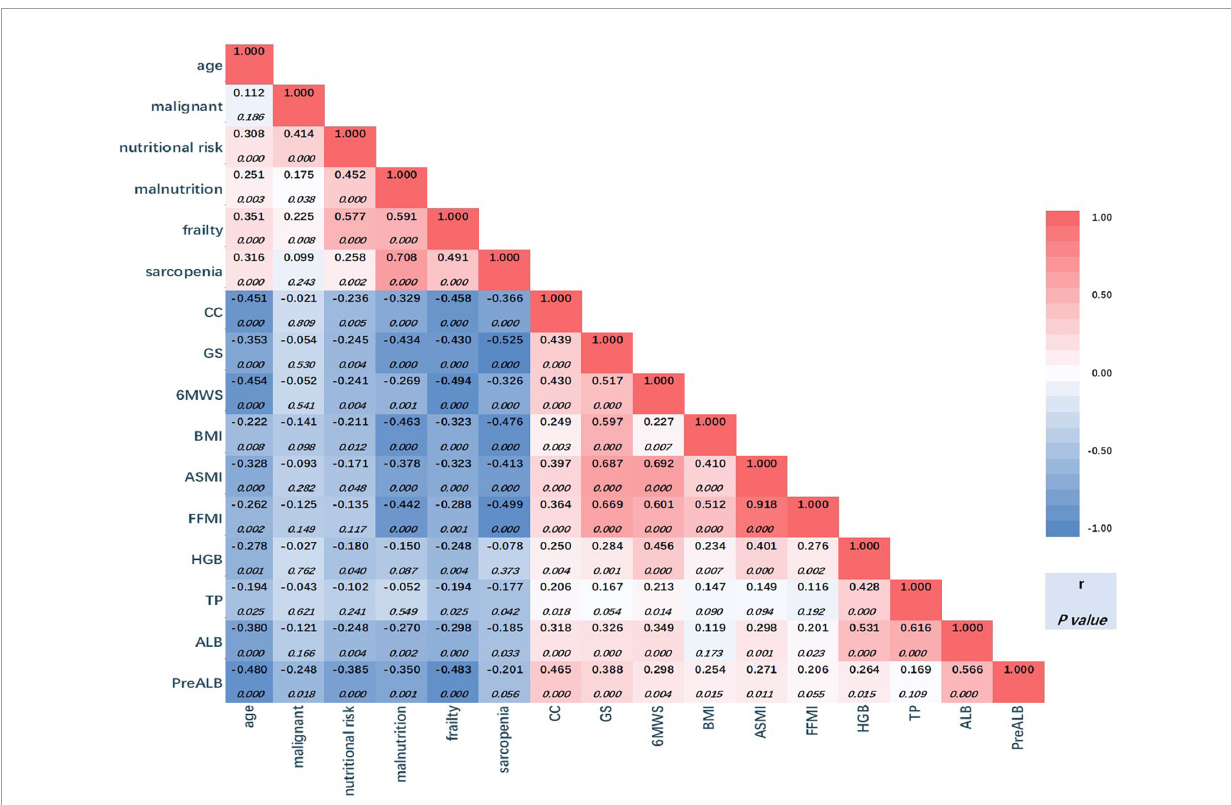
FIGURE3 Correlation heatmap. The correlation coefficient numbers (r) are presented in the triangle, red for positive association, and blue for negative association. Darker colors indicate stronger associations (larger coefficient numbers). The significance levels for coefficients are presented below the r. CC, calf circumference; GS, grip strength; 6MWS, 6-meter walking speed; BMI, body mass index; ASMI, appendicular skeleton muscle index; FFMI, fat free mass index; HGB, hemoglobin; TP, total protein; ALB, albumin; PreALB, prealbumin.